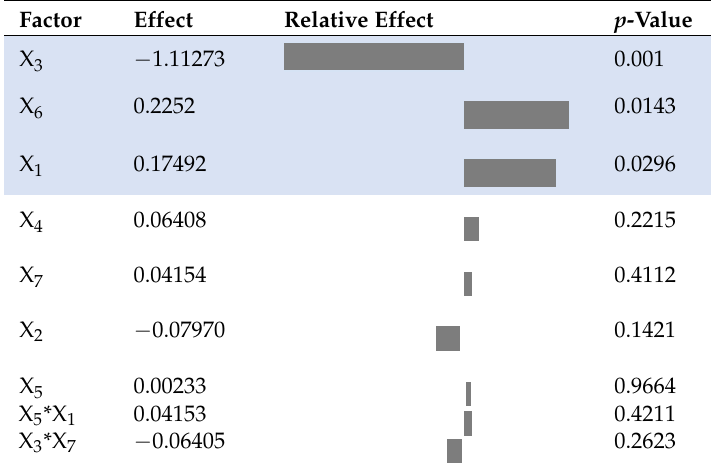
12 of 27 12 of 27 12 of 27